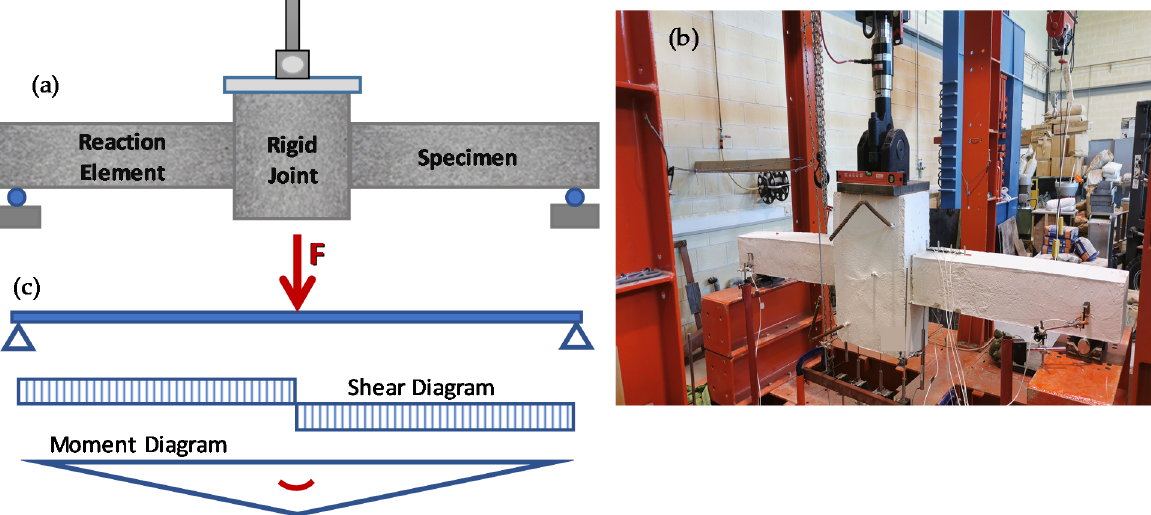
Figure 2. ( a ) Test setup; ( b ) Picture of actual setup; ( c ) Moment and shear diagrams of the simply supported assembly.